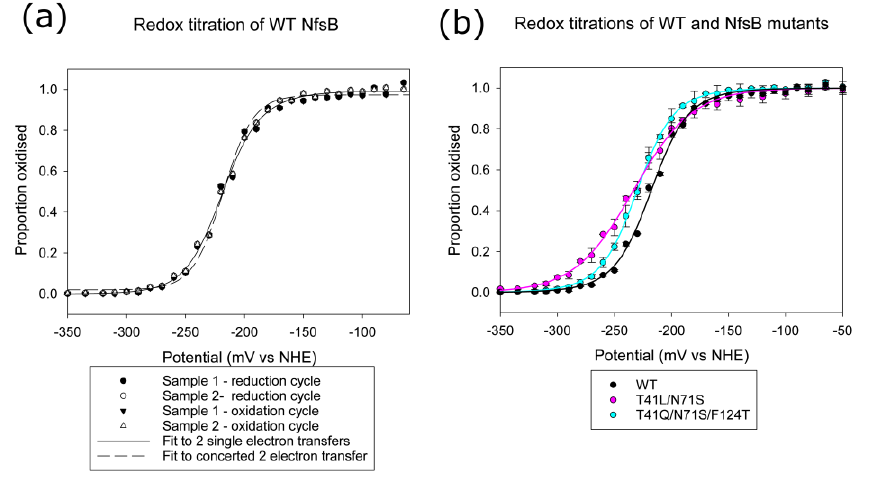
Figure 2. Potential titration of NfsB. Titrations were performed with 50–100 µ M protein in 50 mM phosphate buffer, pH 7.5, 500 mM KCl, 10% glycerol, in the absence of redox mediators, with two aliquots of the same enzyme preparation. ( a ) Titration of wild-type NfsB; circles show the reduction cycles, triangles show the oxidation cycle, black symbols show sample 1, and white symbols show sample 2. The solid line shows the fit of the data to 2 single electron transfer steps (Equation (1)) with potentials − 231 mV and − 204 mV, while the dashed line shows the fit to a concerted 2-electron transfer (Equation (2)) with potential − 218 mV. ( b ) Titration of wild-type NfsB (black circles), T41L/N71S NfsB (magenta circles), and T41Q/N71S/F124T NfsB (cyan circles). The circles show the scaled data from both titrations for each protein, with their error bars, while the lines show the fit of the data to 2 single electron transfer steps (Equation (1)). Wild-type enzyme was fitted as in ( a ), T41L/N71S was fitted to potentials − 215 mV and − 252 mV, and T41Q/N71S/F124T was fitted to − 245 mV and − 215 mV.